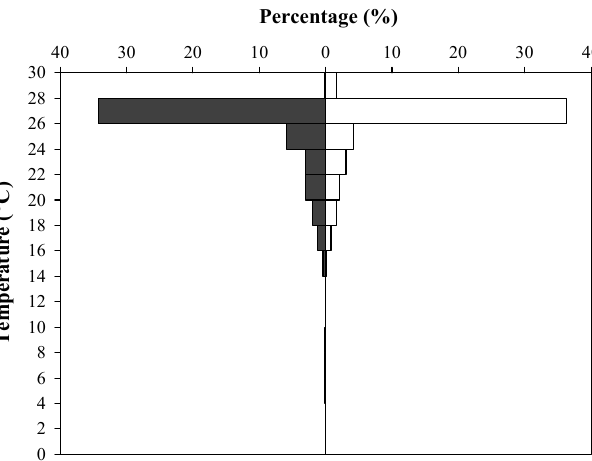
Fig. 4. Percentage of time spent in different temperature for 7 tagged yellow fi n tuna in a total of 189 days. □ : Nighttime and ■ :